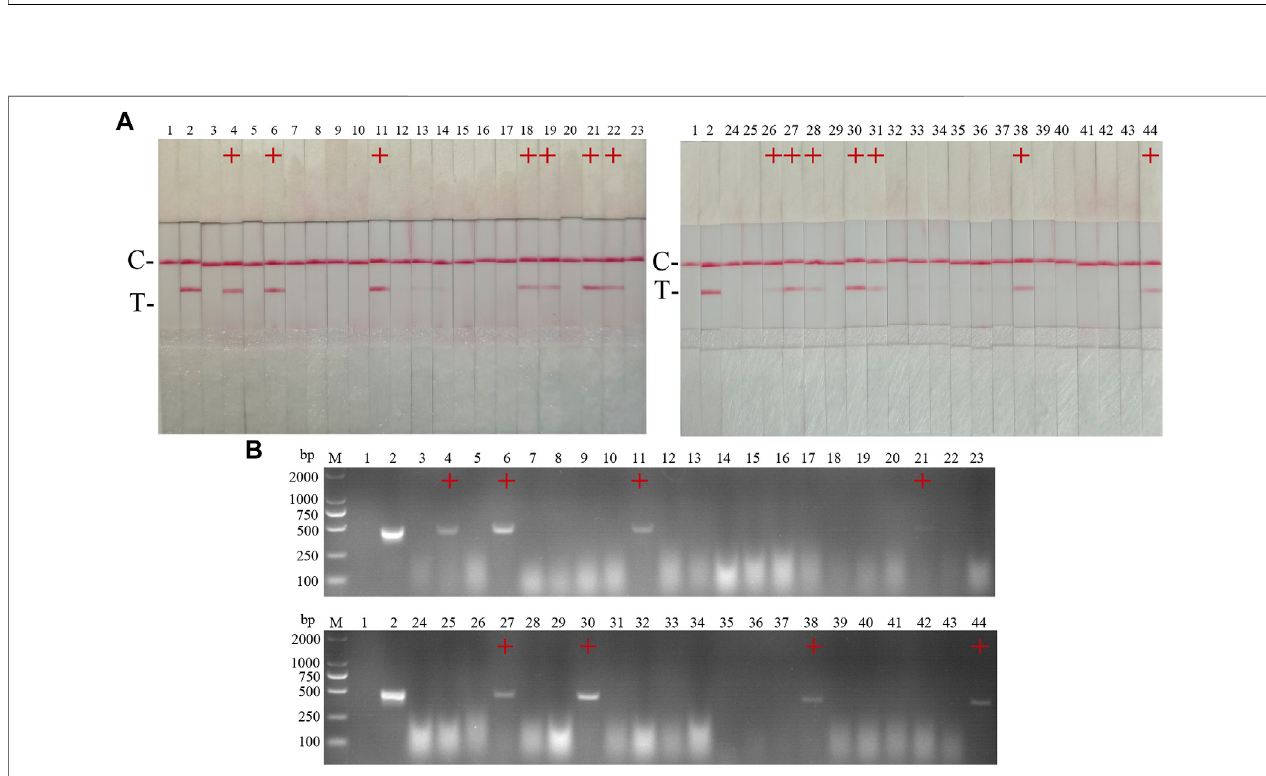
FIGURE 12 | Performance of CSFV RAA-strip on clinical samples. (A) The result of clinical samples detection by CSFV RAA-strip. (B) The result of clinical samples detectionbyCSFVconventionalPCR.Cisacontrolline.Tisatestline.Misa2,000 bpDNAmarker,1isanegativecontrol.2ispositivecontrol(3 – 44)aredifferentclinical pig samples reserved in our laboratory, and “ + ” indicates positive detection of CSFV in the samples.